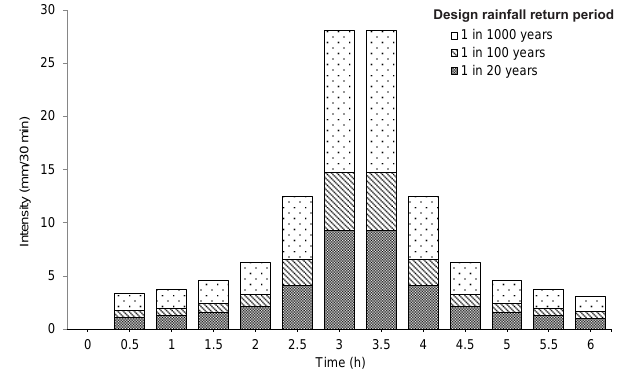
Figure 2. Design rainfall scenarios for the 1 in 20-, 1 in 100- and Figure 2: Design rainfall scenarios for the 1 in 20-, 1 in 100- and 1 in 1,000-year surface water flood modelling conducted by Leicester City Council. 1 in 1000-year surface water flood modelling conducted by the Le- icester City